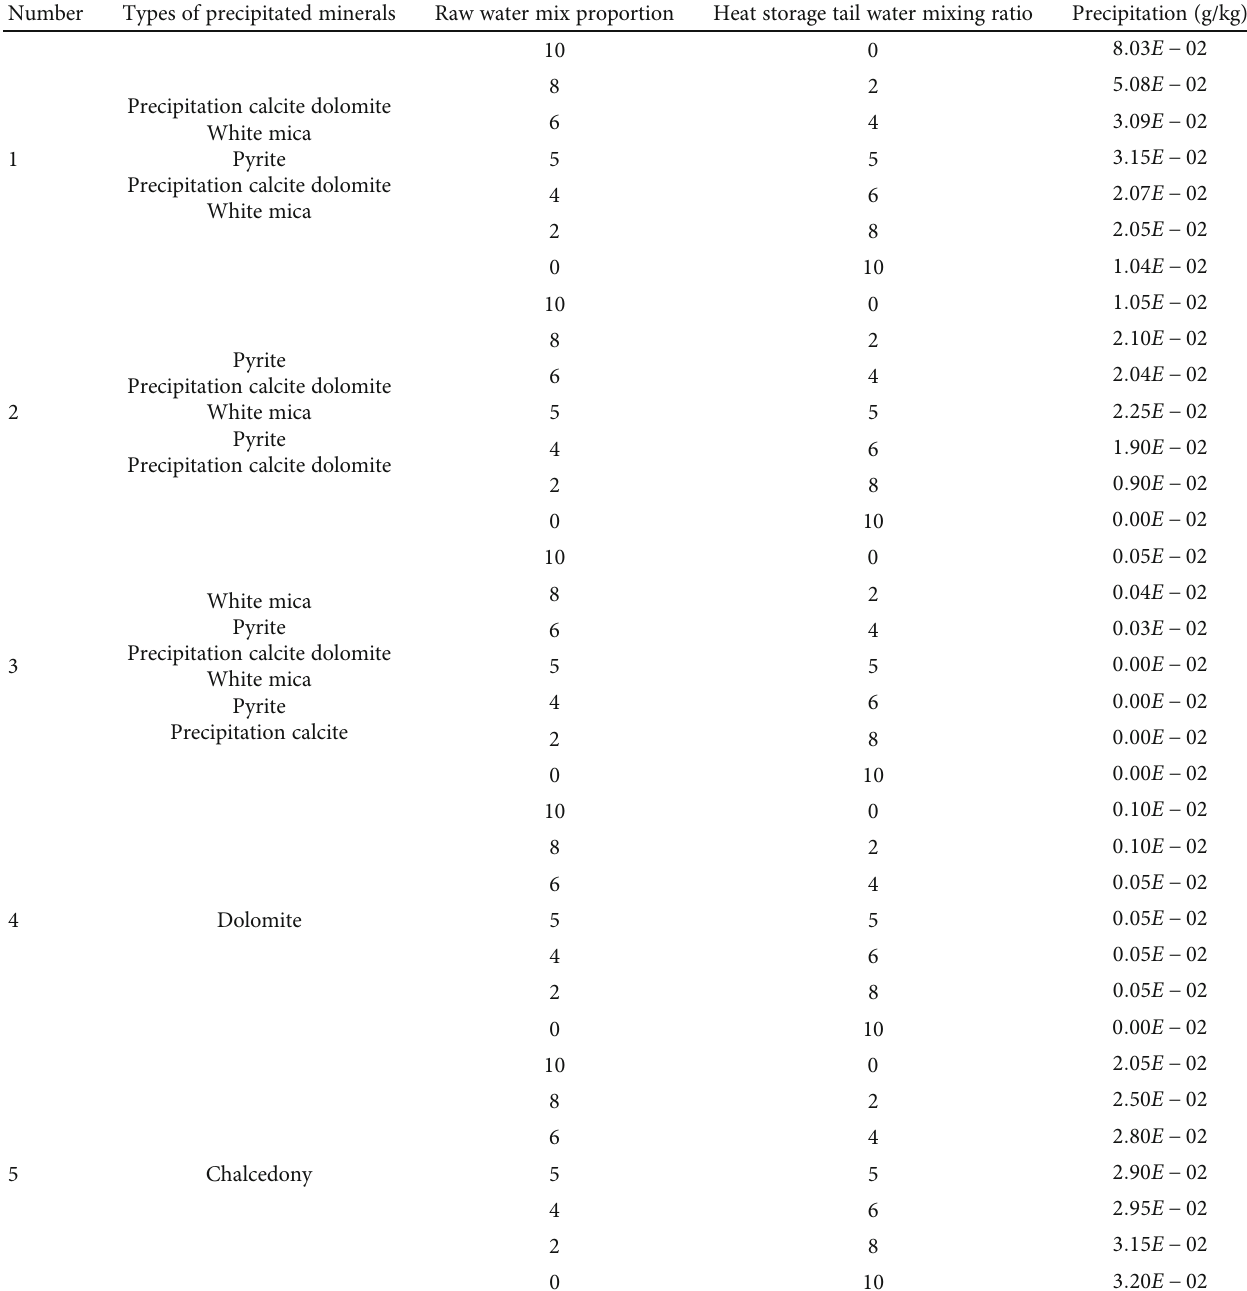
Table 2: Precipitation of precipitated